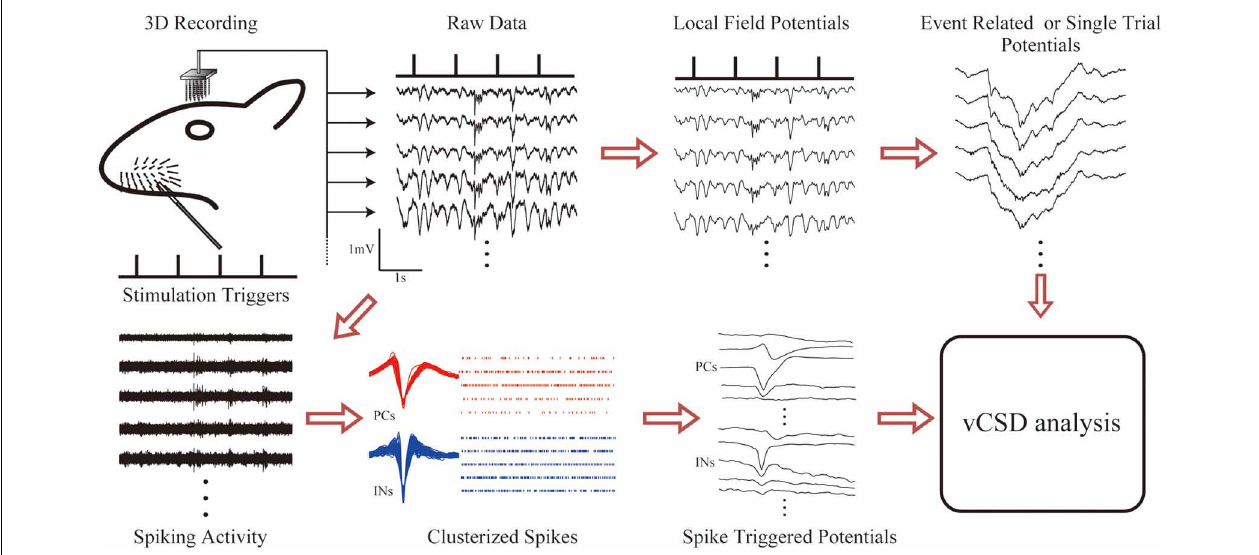
FIGURE 4 | The methodology for fast assessments to the electrical activity of cortical networks in the barrel field of Wistar rats. Electric potentials recorded with the 3D array under single whisker deflections are divided into LFPs and unit activities via corresponding band-pass filters (1–500Hz for LFPs and 0.5–8.0kHz for unit activity). Event related and single trial potentials are computed from the LFPs. The spike triggered